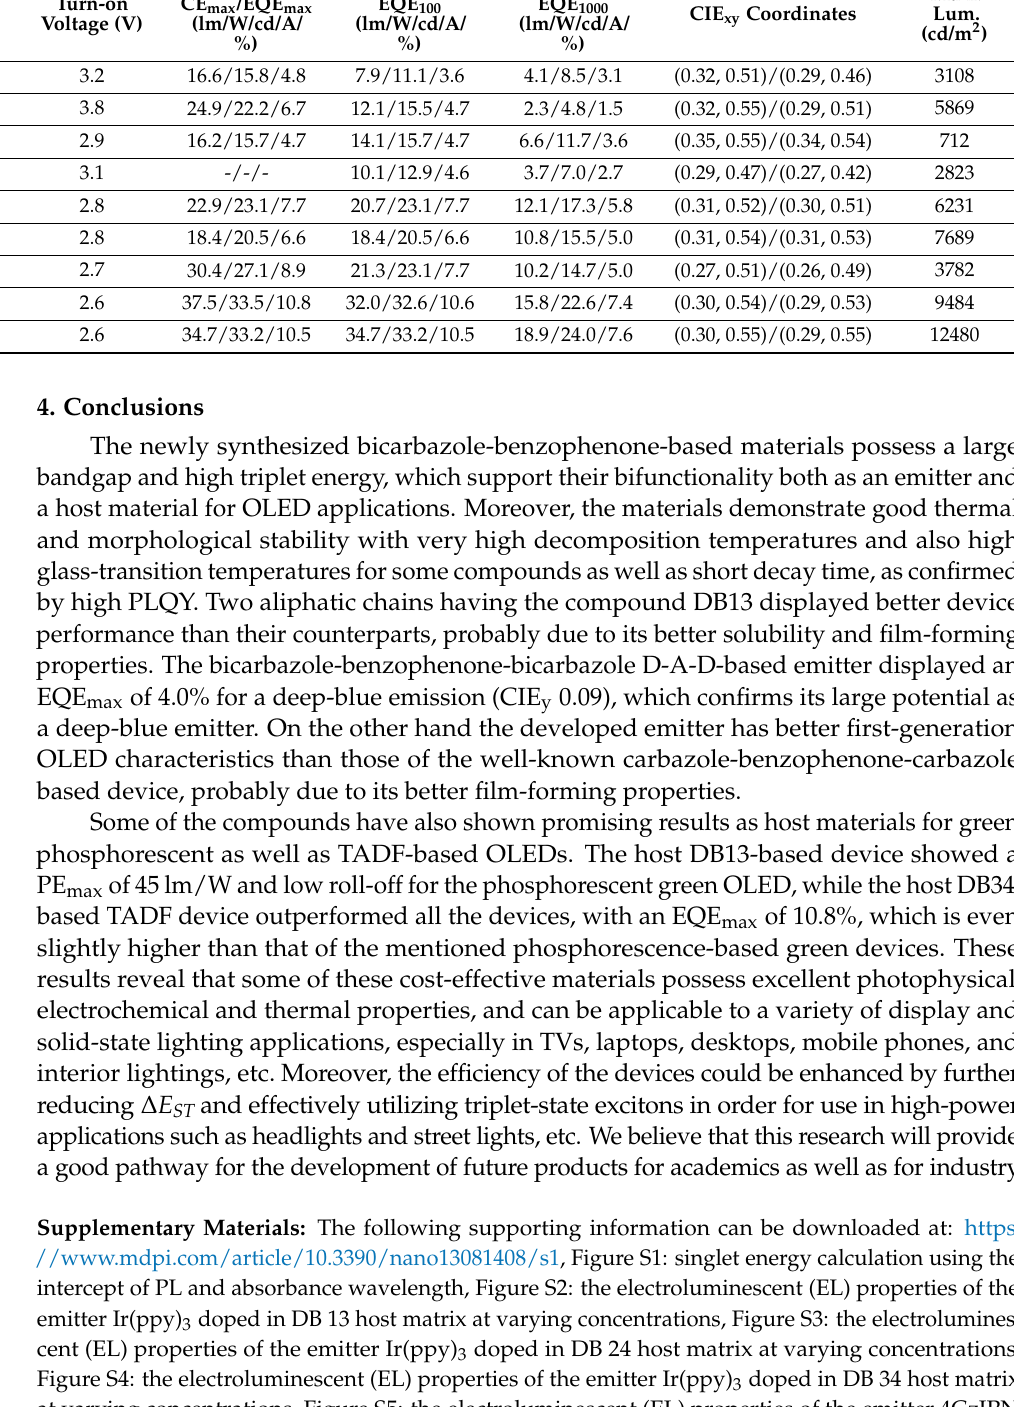
Figure S4: the electroluminescent (EL) properties of the emitter Ir(ppy) 3 doped in DB 34 host matrix at varying concentrations, Figure S5: the electroluminescent (EL) properties of the emitter 4CzIPN doped in DB 23 host matrix at varying concentrations, Figure S6: the electroluminescent (EL) prop- erties of the emitter 4CzIPN doped in DB 23 host matrix at varying concentrations, Figure S7: The electroluminescent (EL) properties of the emitter 4CzIPN doped in DB 34 host matrix at varying concentrations, description of experiments of synthesis with references